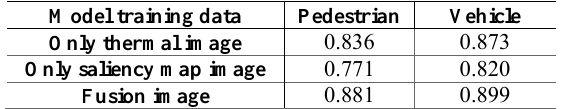
Table 1. The average precision (AP) of the different models trained on different